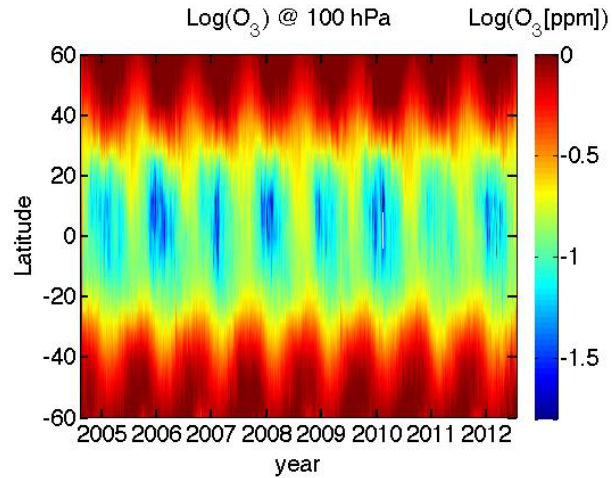
Fig. 11. Speed of the meridional branch (dashed black, left y-axis) of the BDC to the NH at 100 hPa and the average equatorial zonal wind at 32 hPa (solid blue, right y-axis). The meridional speed is in phase with the wind and increases (decreases) as suggested by Fig. 9 during the westerly/positive (easterly/negative) phase of the zonal wind u.